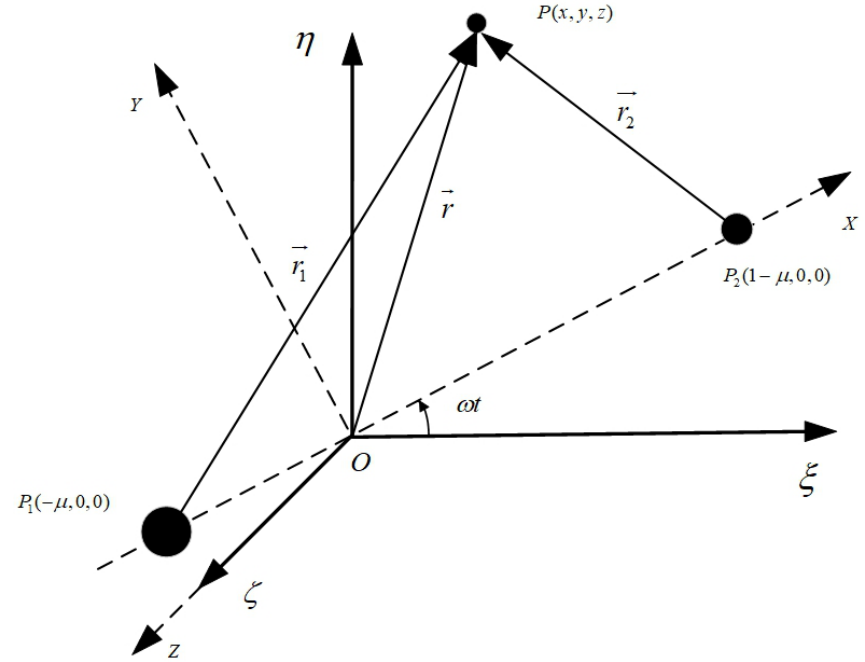
Figure 1. Circular Restricted Three-body